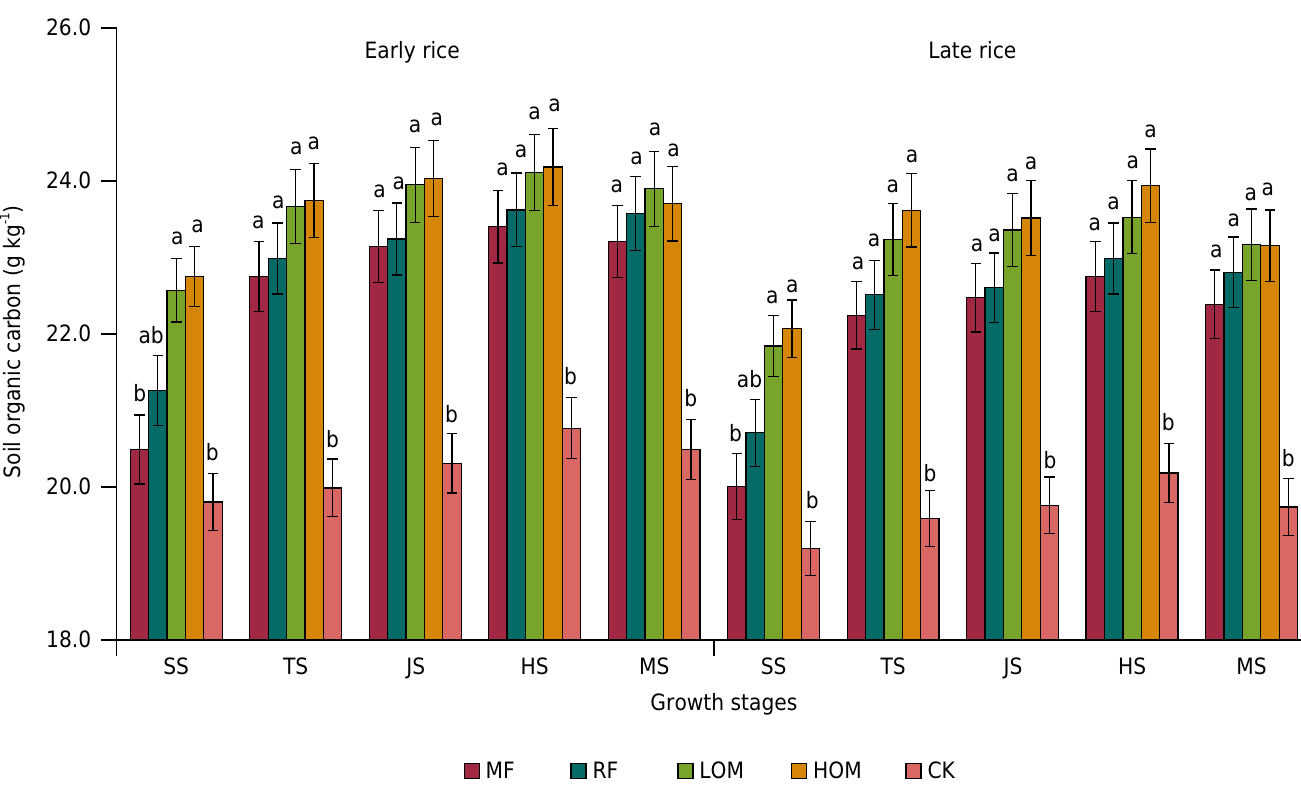
Figure 1. Effects of different long-term fertilization treatments on soil organic carbon content in a paddy field at main rice growth stages. MF = mineral fertilizer alone; RF = rice straw residues and mineral fertilizer; LOM = 30 % organic matter and 70 % mineral fertilizer; HOM = 60 % organic matter and 40 % mineral fertilizer; CK = without fertilizer input; SS = seedling stage; TS = tillering stage; JS = jointing stage; HS = heading stage; MS = mature stage. Bars represent standard deviation (SD) of three replicates. Different letters indicate significance at p < 0.05 among the fertilization treatments at the same rice growth stage, according to the least significant difference